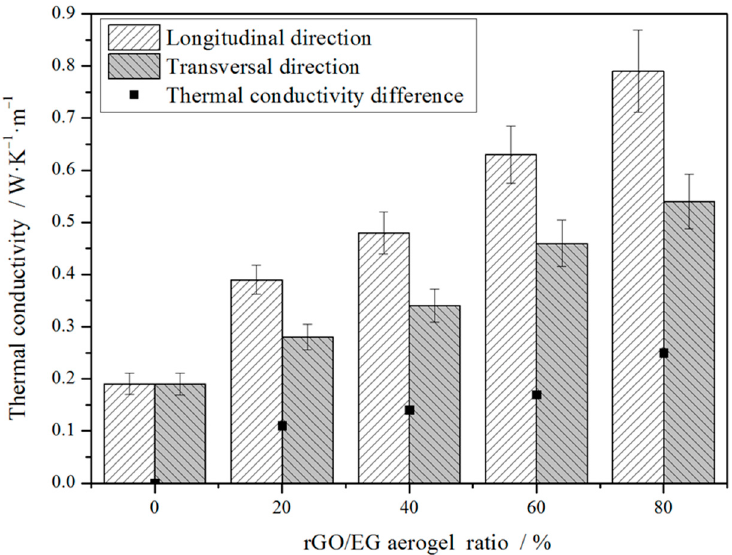
Figure 8. Thermal conductivity of composite PCMs versus rGO/EG aerogel ratios.